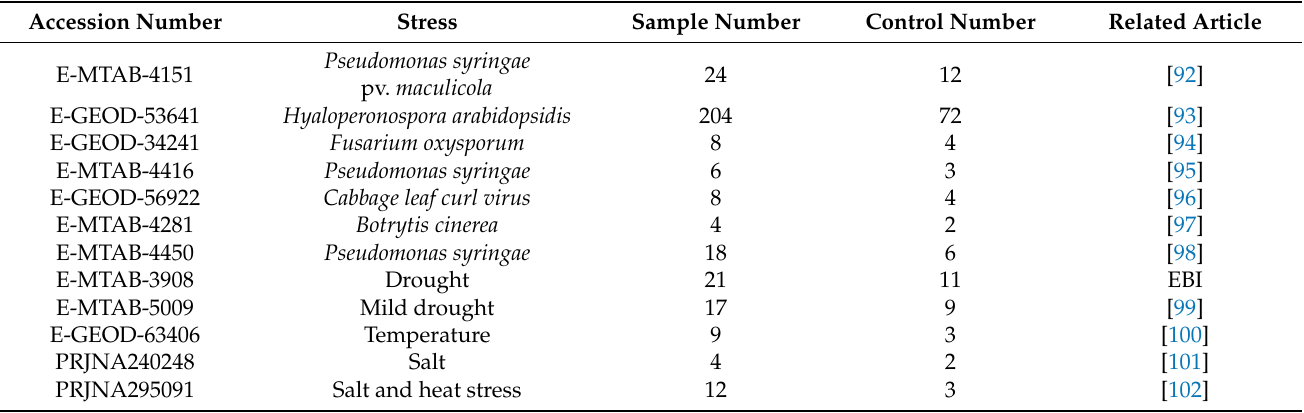
Table 3. Transcriptomic raw data related to different biotic and abiotic stress studies of Arabidop- sis thaliana used for the current